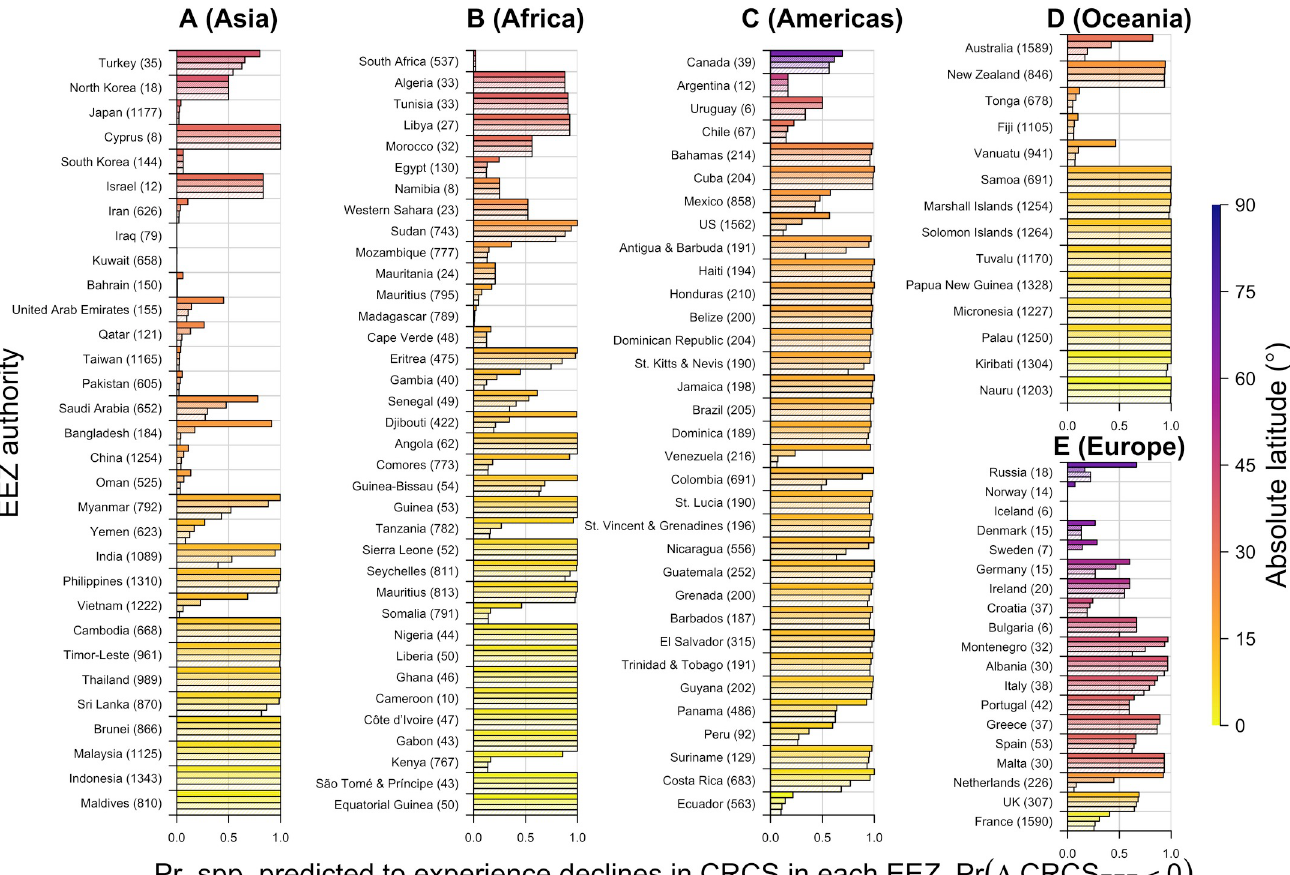
Fig 5. The proportion of species predicted to experience declines in the index of thermal habitat suitability (CRCS) under future sea surface temperature change in the coastal areas of all Exclusive Economic Zones (EEZs) containing more than five modelled species, in (A) Asia, (B) Africa, (C) the Americas, (D) Oceania and (E) Europe. For each EEZ, four bars are shown, denoting the proportion of species predicted to experience declines in CRCS in the EEZ (Pr( Δ CRCS EEZ < 0)), under mid-century RCP 4.5 (bottom bar, lightest hatching) and RCP 8.5 (second bar) and late-century RCP 4.5 (third bar) and RCP 8.5 (top bar, densest hatching) experiments. For each EEZ, the colour of the top bar (the late-century RCP 8.5 experiment) indicates the EEZ’s (absolute) mid-point latitudinal location, which may be influenced by overseas territories. Error bars mark the interquartile range. Numbers in brackets after each EEZ indicate the number of modelled species.